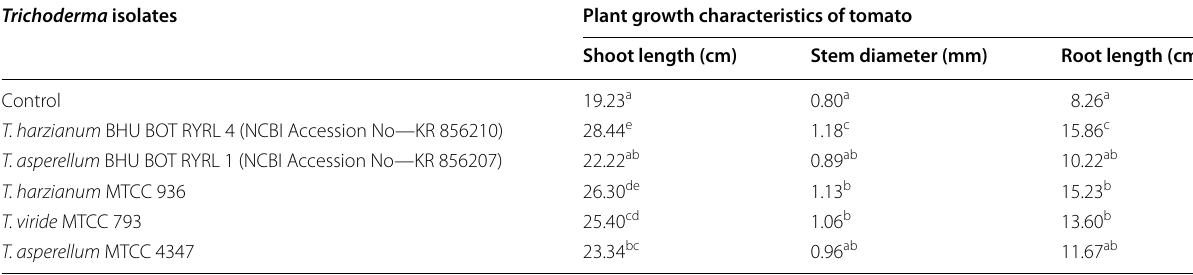
Values followed by the same letters are not significantly different at p